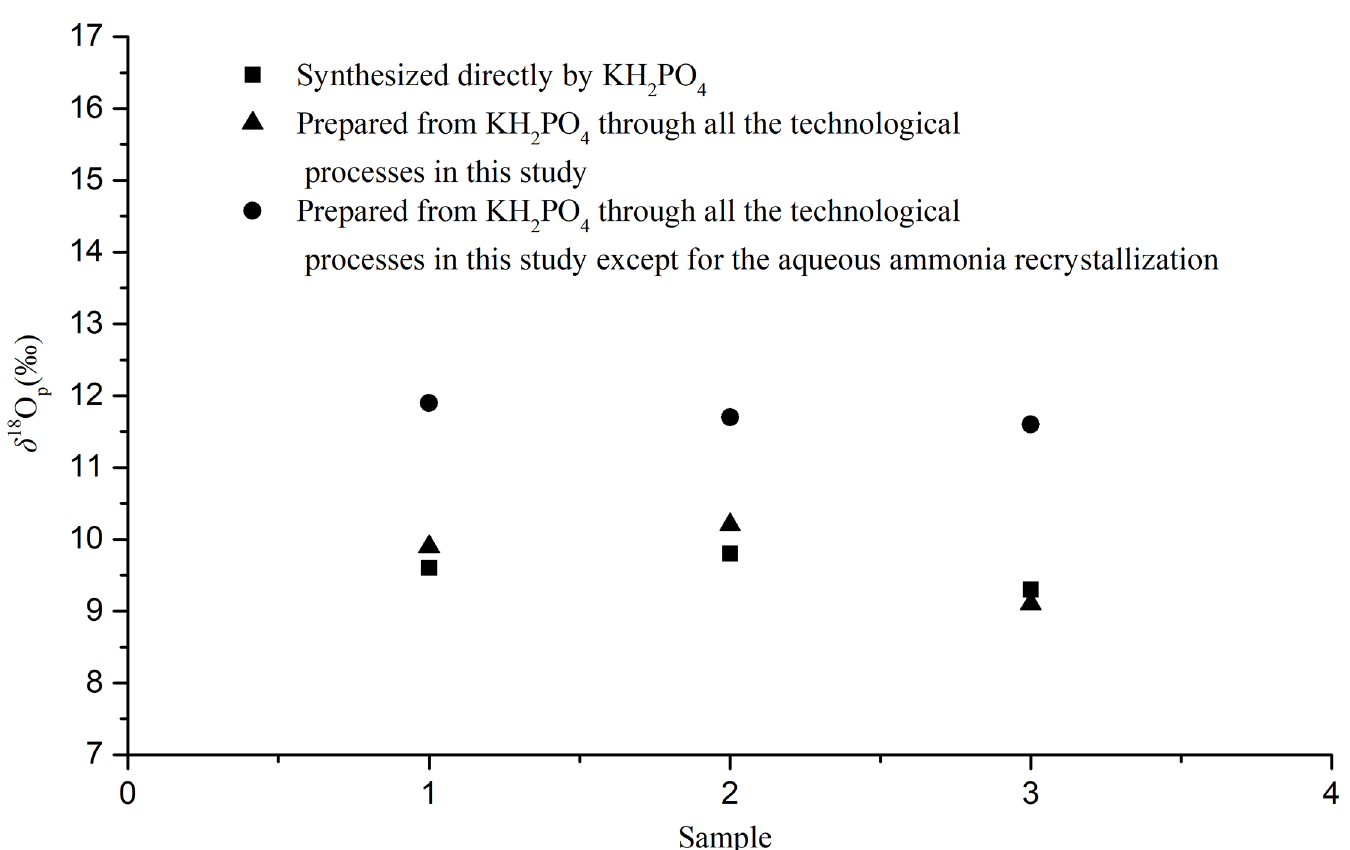
Fig 5. Stable oxygen isotope values of the prepared silver phosphate by different